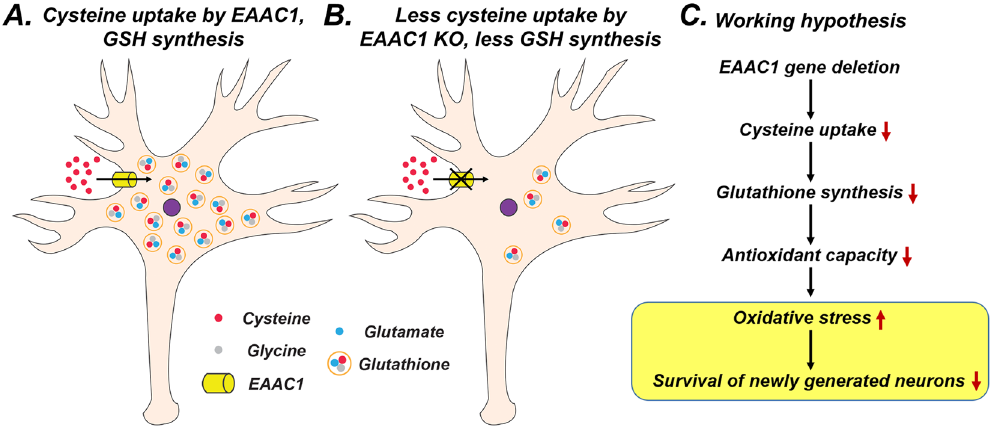
Figure 7. Proposed mechanism by which EAAC1 knockout reduces the survival of newly generated neurons. This schematic drawing indicates several chain reactions that are thought to occur after impairment of neuronal cysteine transport in EAAC1 − / − mice. ( A ) EAAC1 -mediated cysteine transport is essential for GSH synthesis in neurons. ( B ) Reduced cysteine uptake by EAAC1 knockout can result in reduced GSH synthesis. ( C ) Genetic deletion of EAAC1 attenuates neuronal antioxidant capacity by reduced GSH synthesis. This can create enhanced oxidative stress which subsequently has a negative impact on the survival of newly generated